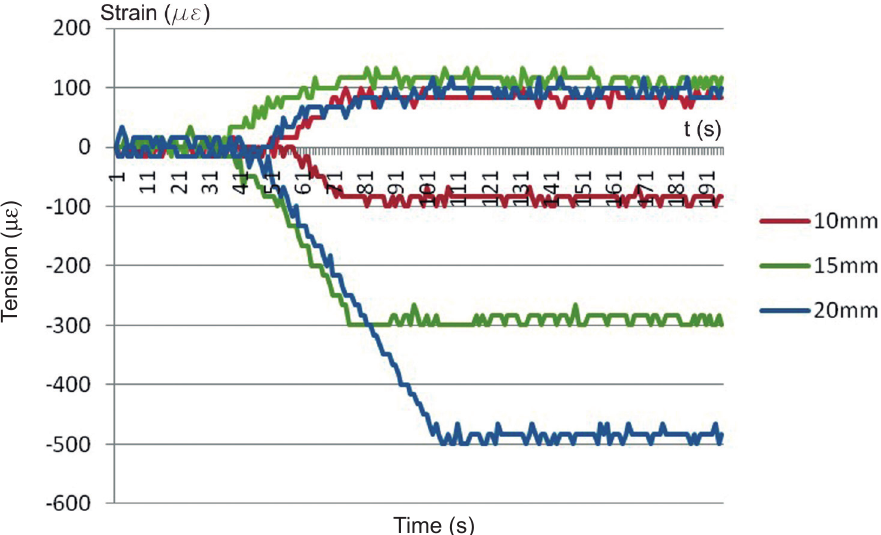
Figure 8- Measurements for tension (positive values) and compression (negative values) in different points of force application for Acrylic Resin group